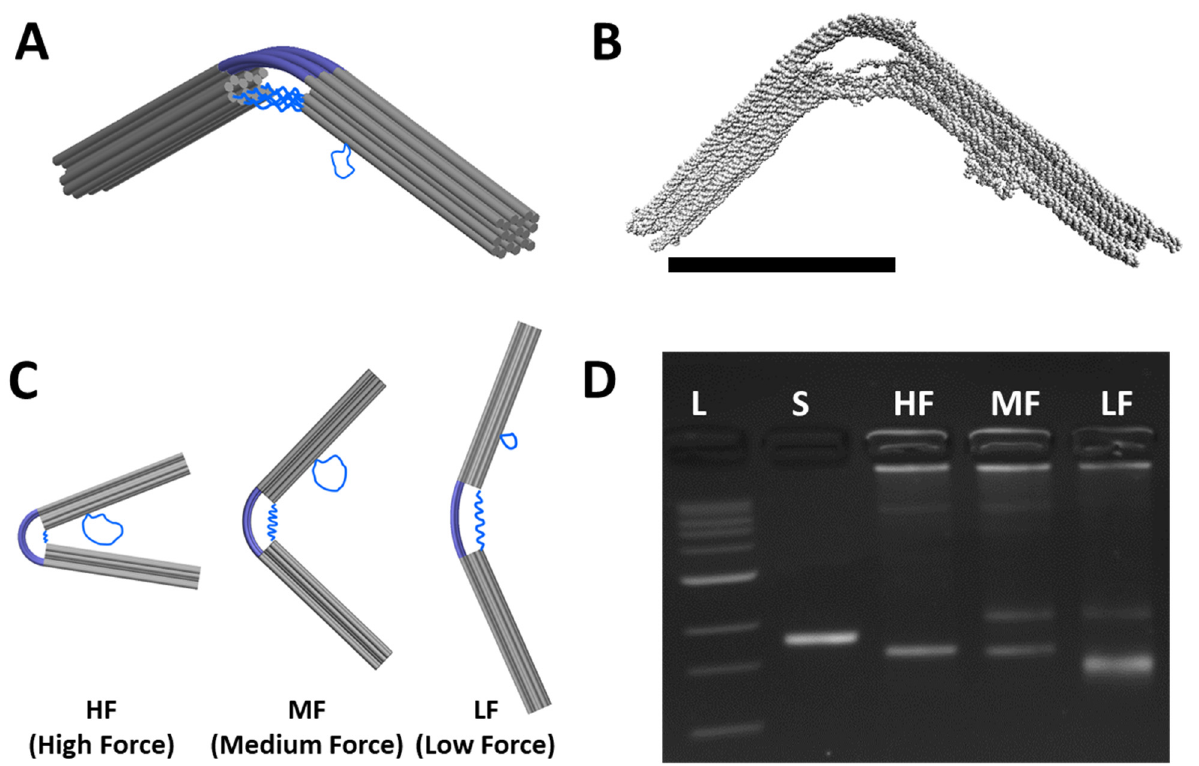
Figure 2. Design and folding of the CHJ. ( A ) The cylinder model schematic of the compliant hinge joint (CHJ) made up of two arms (grey), a 6-helix dsDNA compliant layer connection at the joint (blue, top), 6 ssDNA linkers that span across the bottom of the joint (blue, bottom), and a ssDNA reservoir protruding from the bottom of the right arm. ( B ) The molecular model of CHJ simulated by oxDNA and visualized by VMD. ( C ) The length of the ssDNA linkers controls the hinge configuration, which can be altered by shifting ssDNA length between the reservoir and linkers. Shorter ssDNA linkers cause higher force (HF), inducing stronger bending in the compliant layer. Likewise, the middle force (MF) and low force (LF) have longer ssDNA linkers, leading to lower forces that induce less bending in the compliant layer (i.e., larger angles between the hinge arms). ( D ) The 2% agarose gel analysis for the 2.5 day folding protocol reveals a clear shift, indicating the distinct configurations. The L (1 kb ladder) and S (7560 nt scaffold) bands are for reference. Scale bar = 50 nm.